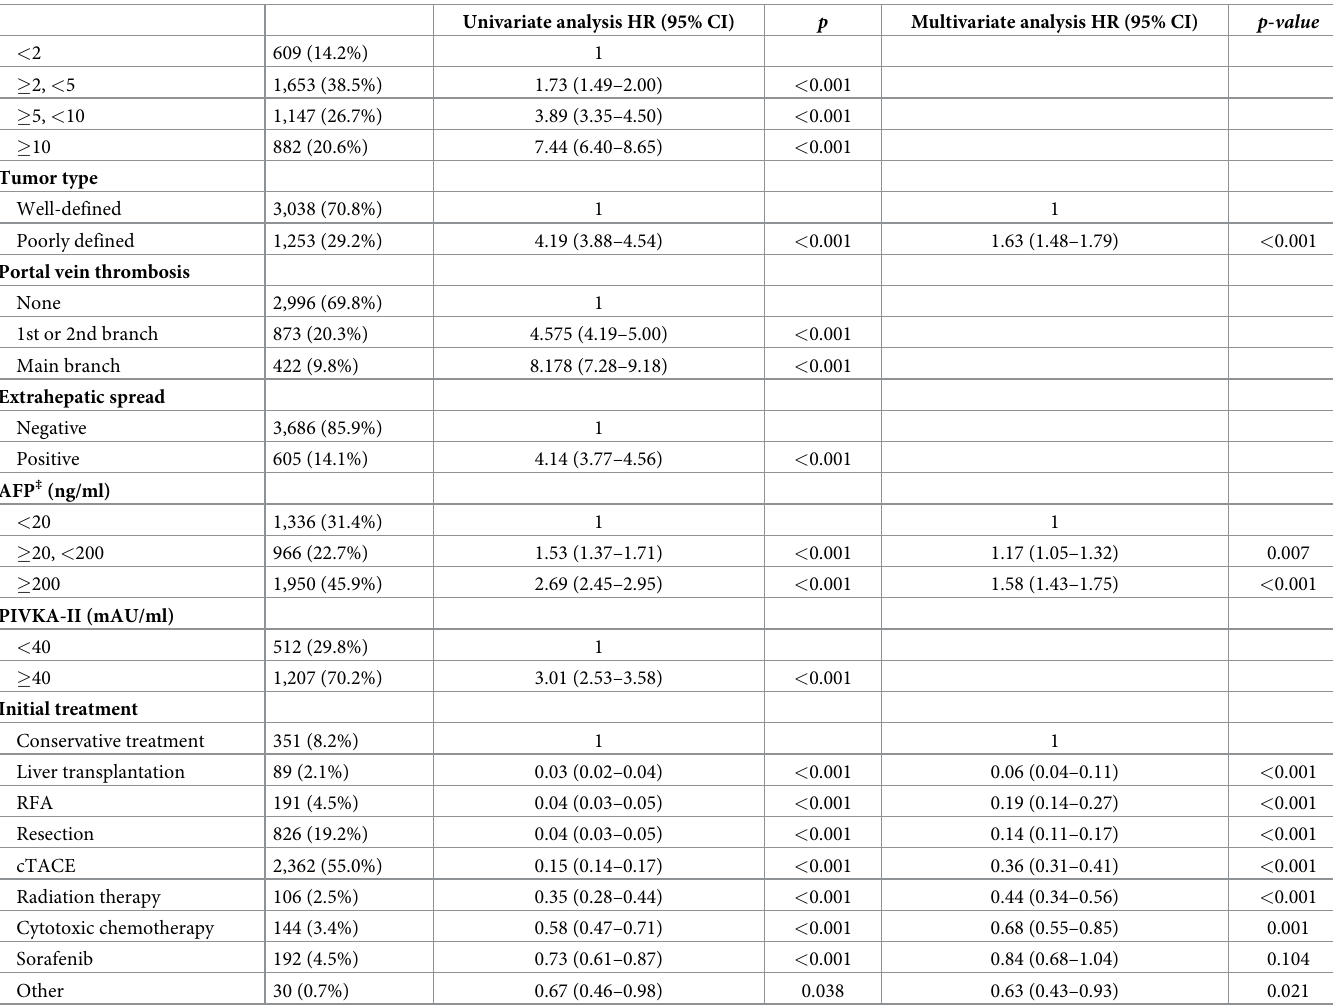
Abbreviations: HBV, hepatitis B virus; HCV, hepatitis C virus; ECOG PS, Eastern Cooperative Oncology Group Performance Status; UICC, Union for International Cancer Control; BCLC, Barcelona Clinic Liver Cancer; MELD, model for end-stage liver disease; AFP, alpha-fetoprotein; PIVKA-II, protein induced by vitamin K antagonist-II; RFA, radiofrequency ablation; cTACE, conventional transarterial chemoembolization.